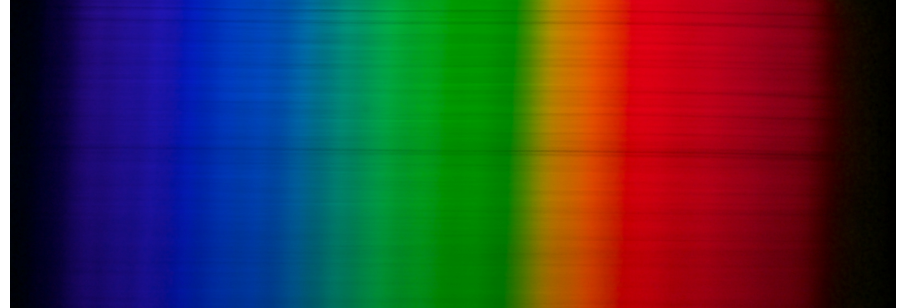
Figure 2. An example diffraction image of a range of monochromatic light, imaged by Nikon D300